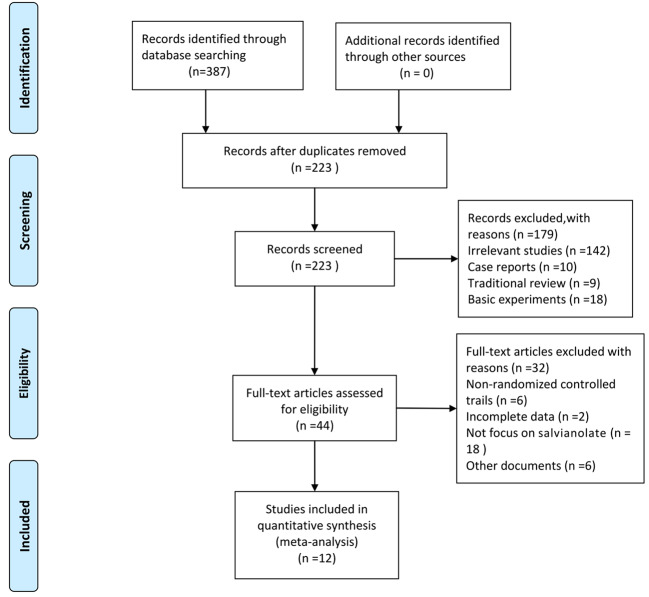
Flow diagram of literature screening.